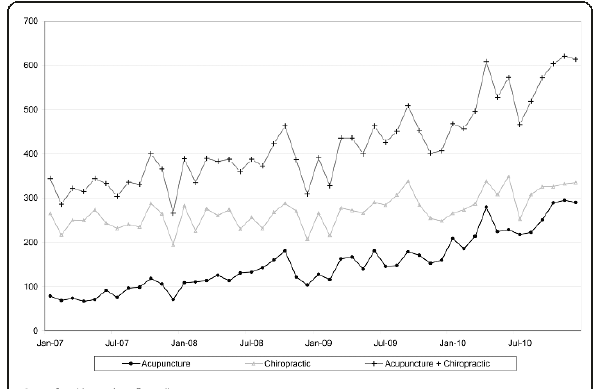
Figure 3 Health Plan Patients with Chronic Musculoskeletal Pain (CMP) Receiving New* Acupuncture and or Chiropractic Care (A/C) Referral